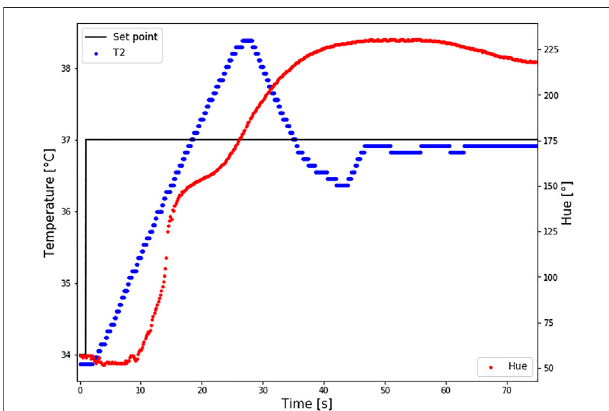
FIGURE 9 | Comparison between LCs patch and IR imaging. Three surfaces (A – C) with different temperature distributions were tested. On the left are digital photosofLCspatchresponsewhenincontactwiththeheatedsurface;ontherightareIRimagesofthesamesurface.Thetemperaturewascalculatedfromthesurfaces marked with white on both digital and IR images. The red square on IR images represents the surface covered by the LC patch.